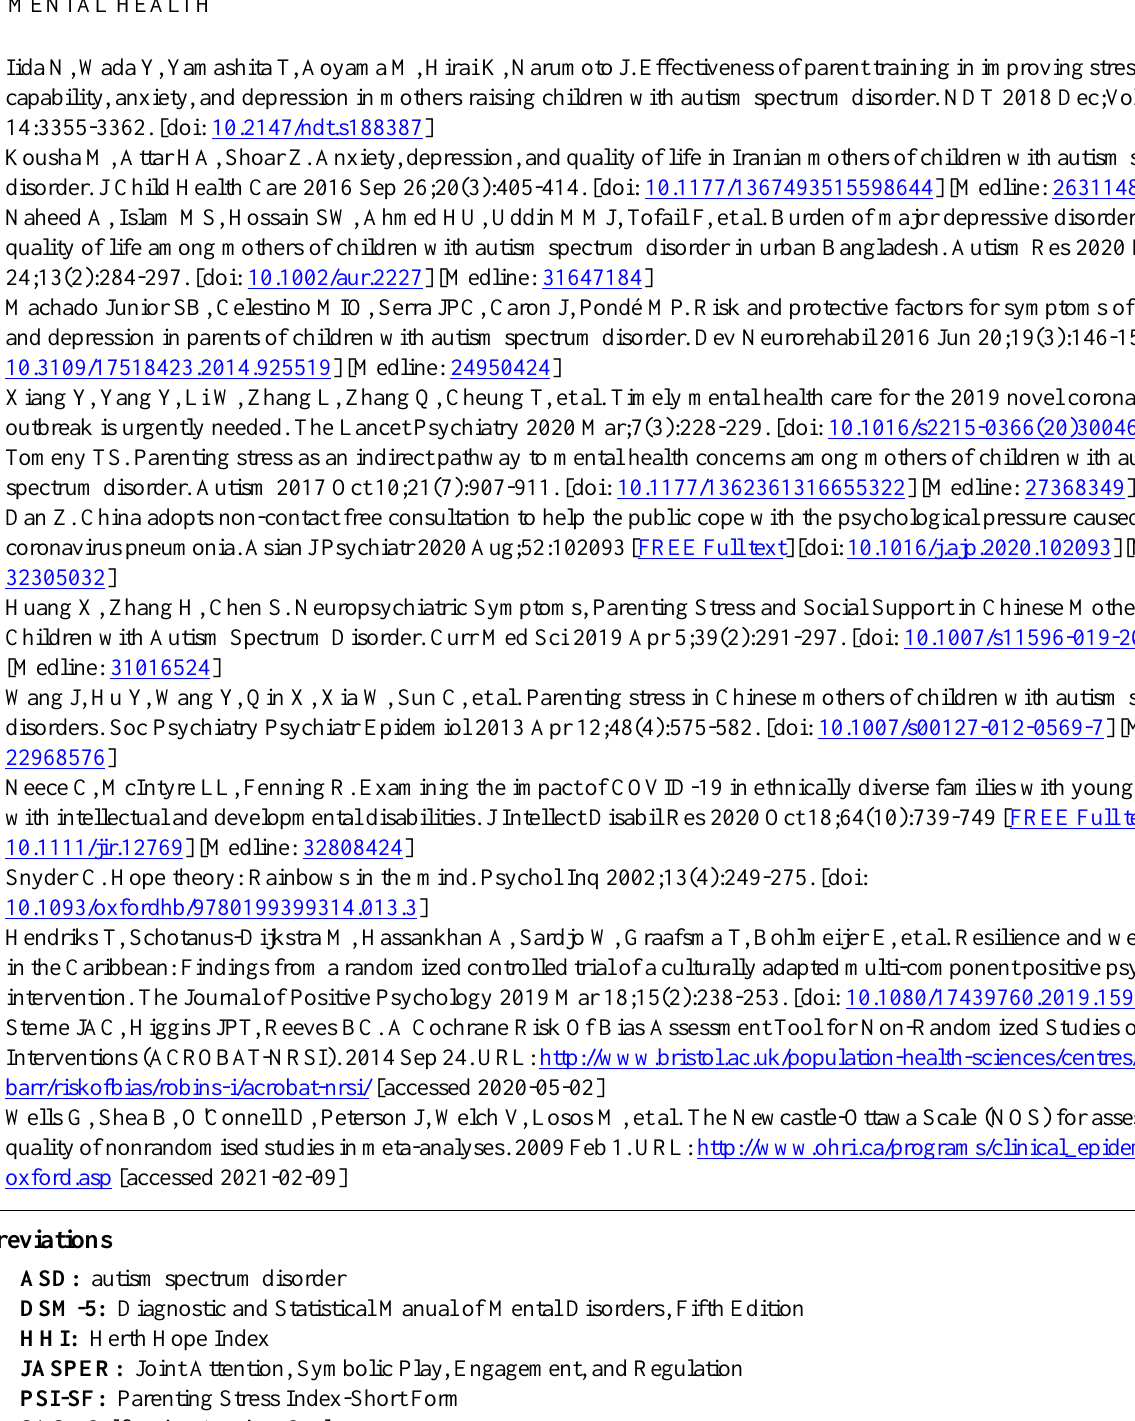
Abbreviations ASD: autism spectrum disorder DSM-5: Diagnostic and Statistical Manual of Mental Disorders, Fifth Edition HHI: Herth Hope Index JASPER: Joint Attention, Symbolic Play, Engagement, and Regulation PSI-SF: Parenting Stress Index-Short Form SAS: Self-rating Anxiety Scale SDS: Self-rating Depression